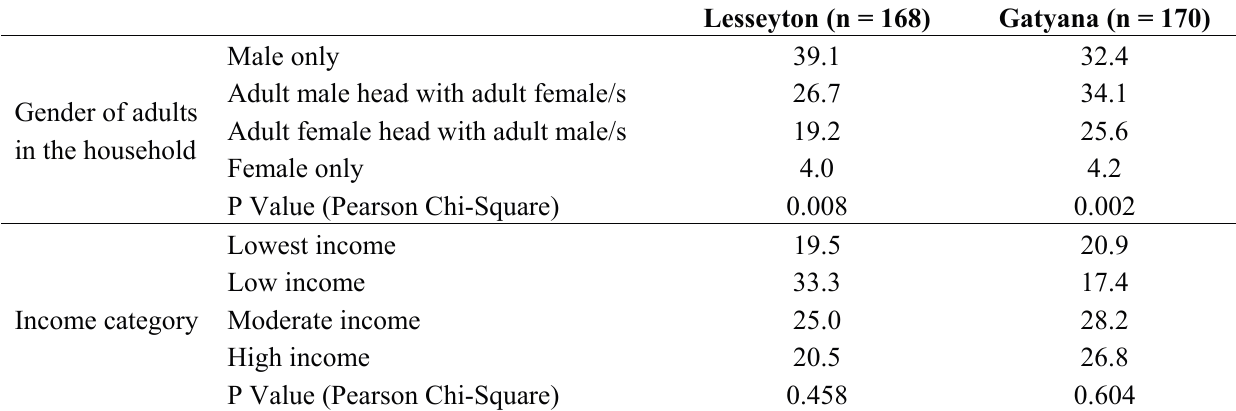
Table 8. Differences in percentages of households purchasing